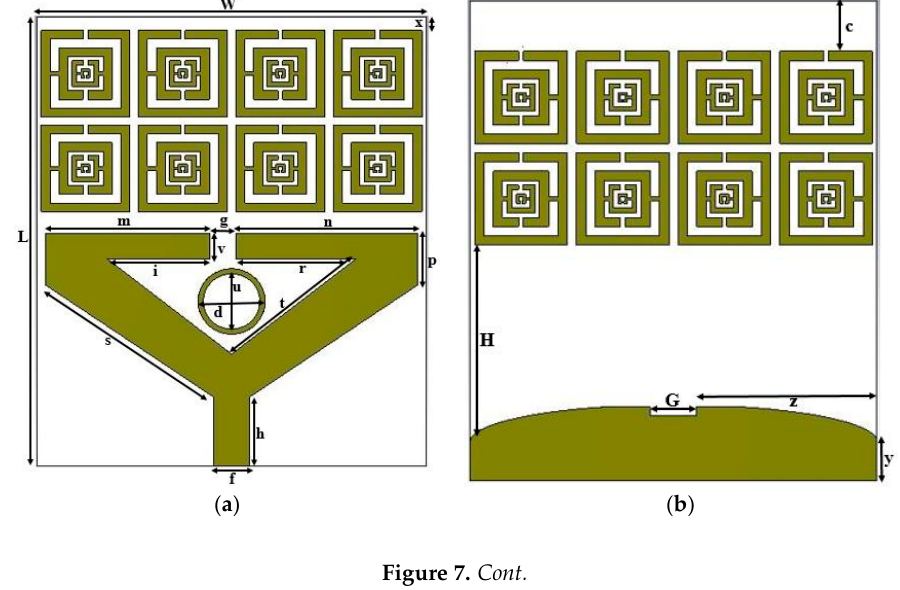
Table 2. Metamaterial (MTM) effective parameters (µ, ε , η ) in the negative index frequency zone.